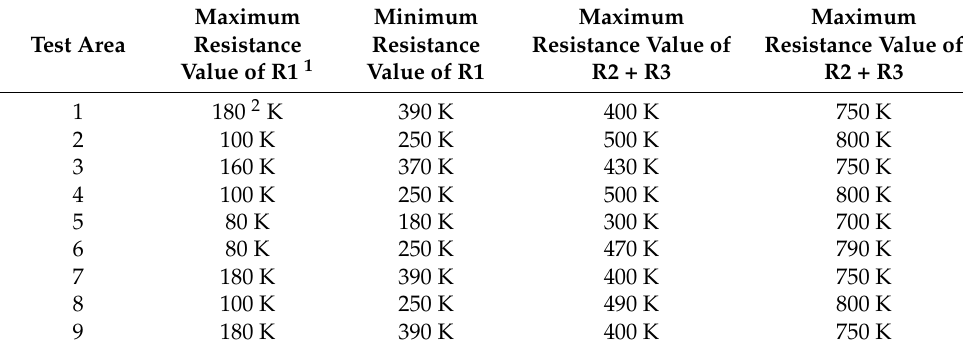
Table 3. Voltage division resistance